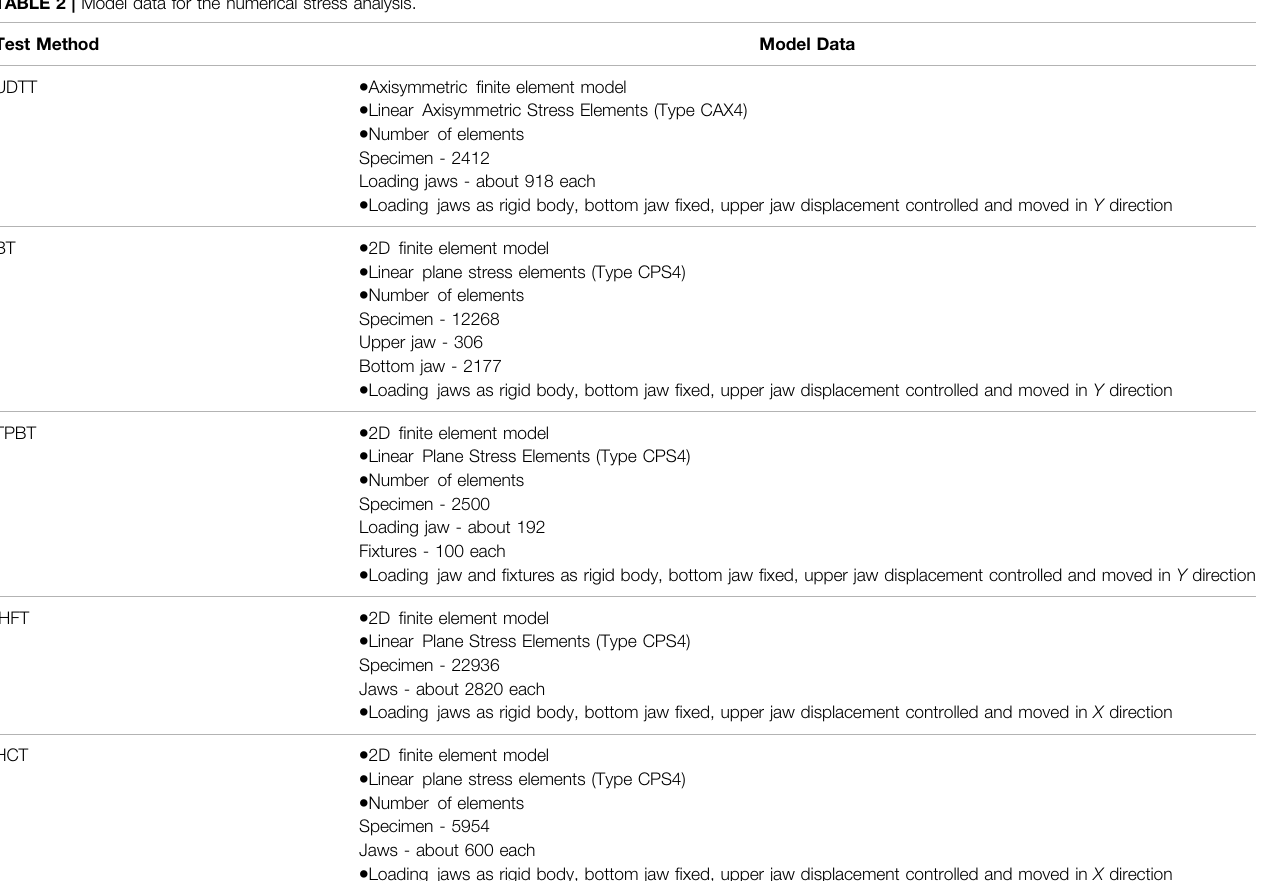
TABLE 2 | Model data for the numerical stress analysis. Test